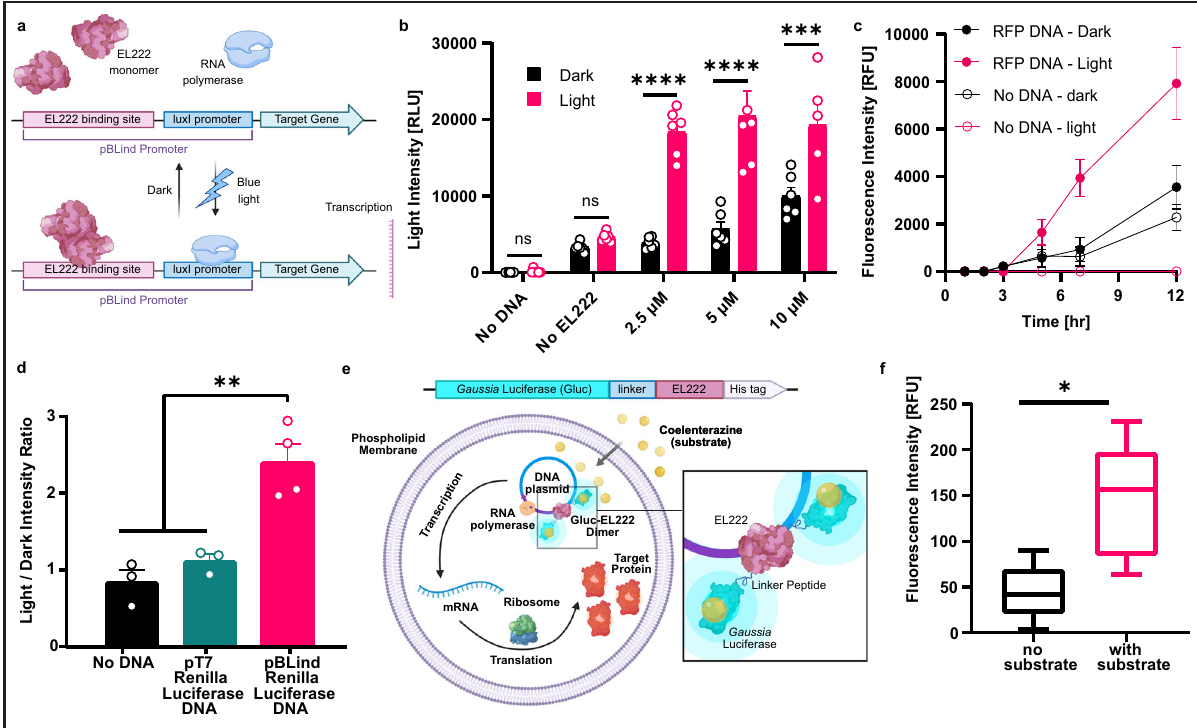
Fig. 4 Bioluminescent signaling self-activates transcription in synthetic cells. a , Illustration of the light-dependent transcription mechanism mediated by the transcription factor EL222. b , EL222 concentration affected the production of Renilla luciferase (Rluc) in cell-free protein synthesis (CFPS) reactions under light and dark conditions. Data is expressed as a mean ± standard deviation ( n = 5 independent samples for 10 μ M EL222 under light conditions, n = 6 independent samples for all other experimental groups). Two-way ANOVA with multiple comparisons test adjusted P -values; ****p = 3.26×10 -8 , ****p = 2.51×10 -8 , ***p = 0.0005, for comparison of light vs. dark conditions of 2.5, 5 and 10 μ M, respectively. c RFP production kinetics in CFPS reactions supplemented with EL222 under dark and light conditions, with or without RFP DNA. Data is expressed as a mean ± s.e.m. ( n = 4 independent samples for the “ no DNA ” groups, n = 6 independent samples for other groups). d Light-to-dark ratio of Rluc expression in synthetic cells containing EL222 and a DNA plasmid expressing Rluc under different promoters. Data is expressed as a mean ± s.e.m. ( n = 4 independent samples for the pBLind promoter group, n = 3 for other experimental groups). One-way ANOVA with multiple comparisons test adjusted P value; **p = 0.0016, **p = 0.005, for comparisons of the pBLind group vs. the no DNA and pT7 groups, respectively. e A block diagram of the Gluc-EL222 fusion protein elements. Below, a schematic representation of a synthetic cells containing the Gluc-EL222 fusion protein for bioluminescent activation of transcription. f RFP production in synthetic cells containing the Gluc-EL222 protein with or without addition of coelenterazine. Horizontal lines indicate median values; boxes indicate quartiles 1 and 3; whiskers indicate the min and max values ( n = 5 independent samples). Student ’ s two-tailed t -test P value; * p = 0.0134. Source data are provided as a Source Data fi